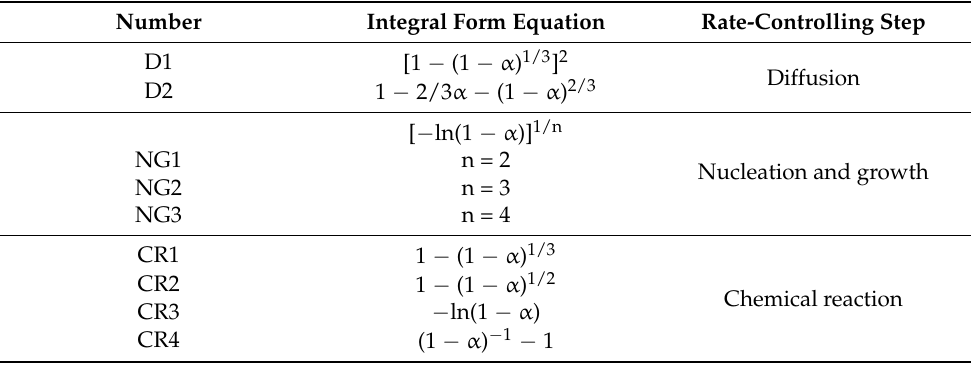
Figure 2. Linear fit of kinetics models: RM without additives ( a ) and with 13.65% Na 2 SO 4 ( b ). Table 2. Kinetic models of the iron reduction